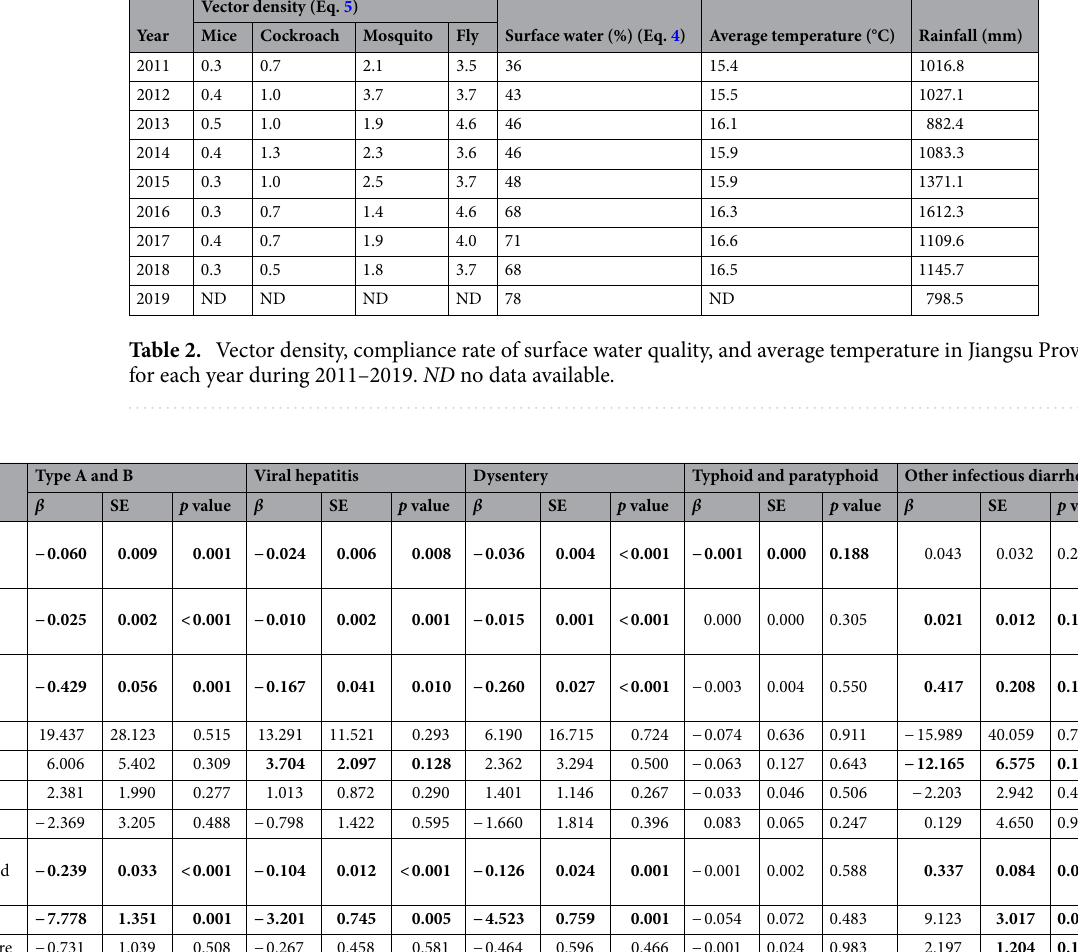
Vector density (Eq. 5) Year